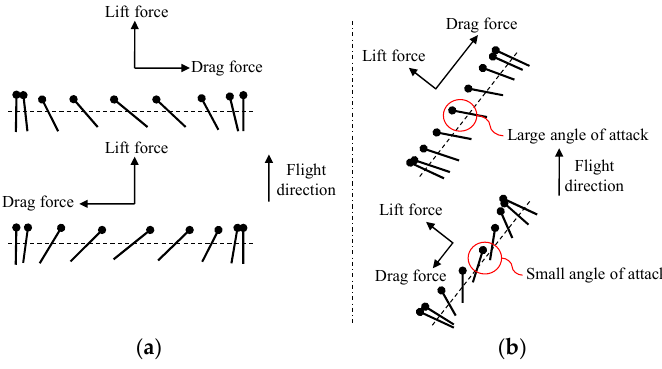
Figure 2. Stroke motion of a ( a ) lift-based system and ( b ) drag-based system.